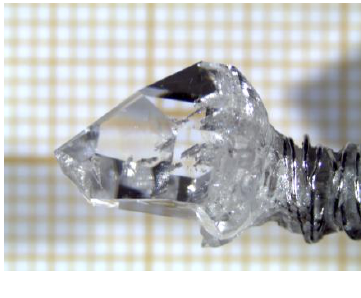
single crystal grown by the top seeded solution growth 2 Mo O 2 4 13